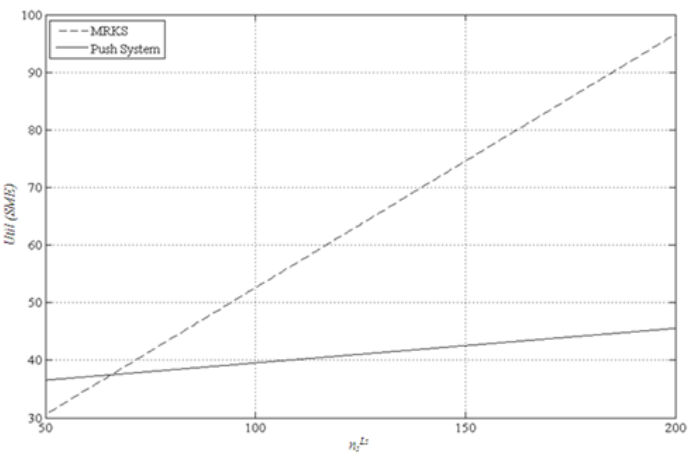
Figure 13. Box plot analysis on utilization of SMEs